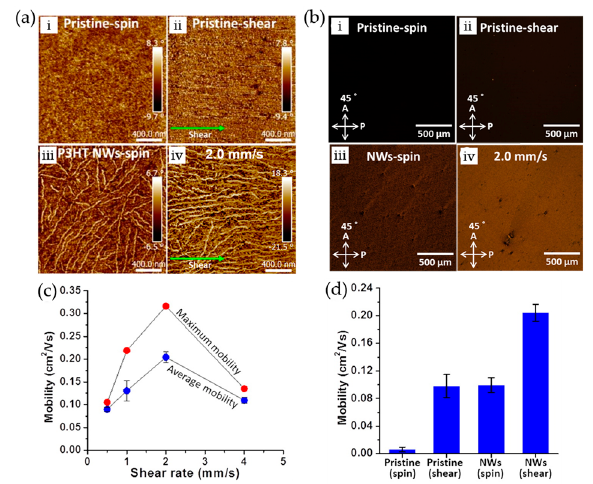
Figure 9. ( a ) AFM and ( b ) POM images of pristine P3HT thin films: (i) spin-coated; and (ii) shear-coated at 2.0 mm/s from a pristine solution; and P3HT NW films: (iii) spin-coated; and (iv) shear-coated at 2.0 mm/s from a P3HT solution containing P3HT NWs. ( c ) Average and maximum field-effect mobilities of P3HT NW films shear-coated as a function of the shearing speed. ( d ) Mobility comparison of P3HT pristine films spin-coated and shear-coated at 2.0 mm/s and P3HT NW films spin-coated and shear-coated at 2.0 mm/s. Reproduced with permission from [55]. Copyright 2016 American Chemical Society.